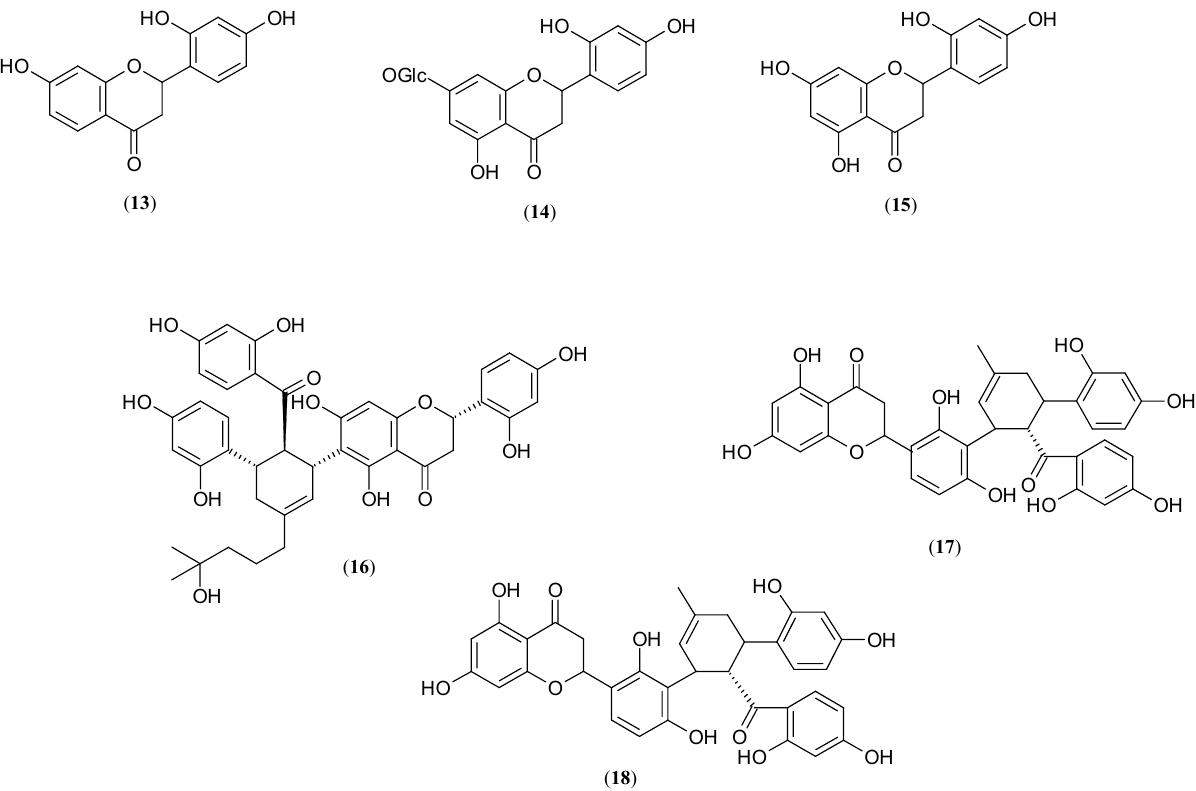
Figure 4. Structures of flavanones and flavonones: 7,2′,4′-trihydroxyflavanone ( 13 ), steppogenin-7-O-β-D-glucoside ( 14 ), steppogenin ( 15 ), sanggenon T ( 16 ), kuwanon O ( 17 ) and kuwanon L ( 18 ) with tyrosinase inhibitory activity isolated from genus Morus .